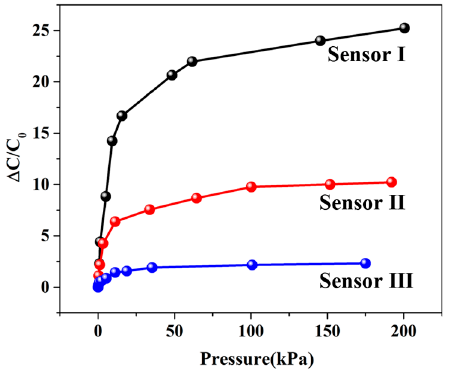
Figure 7. Pressure response curve of the